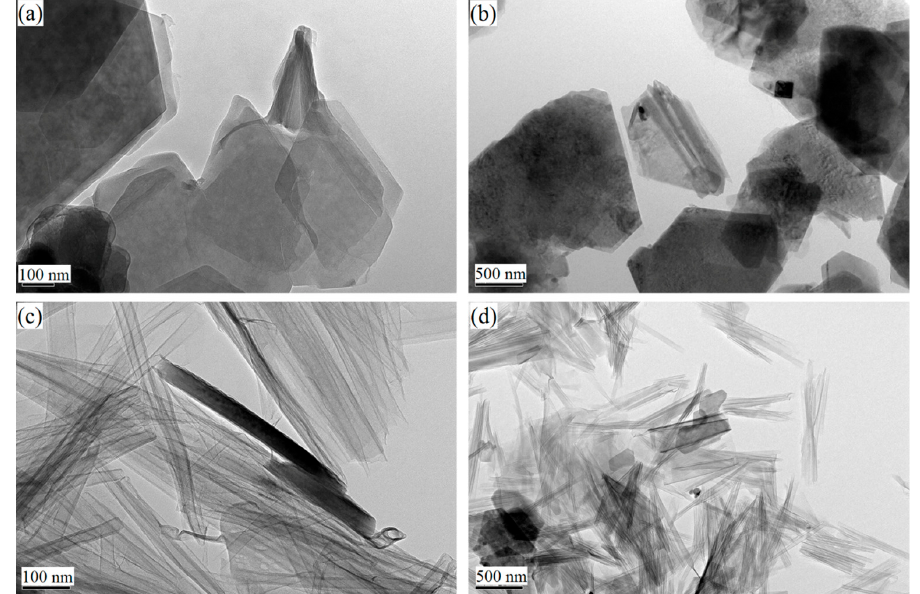
Figure 4. TEM images of ( a , b ) K-Fa-C 18 , and ( c , d ) K-Qa-C 18 .